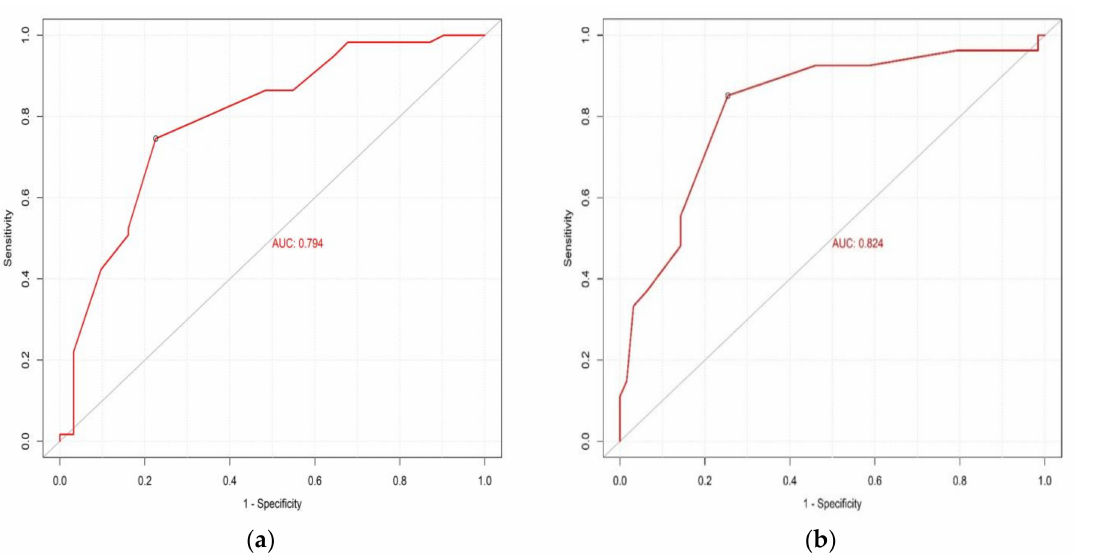
Figure 3. ( a ) Discriminative ability of CC to predict sarcopenia (CC~Sarcopenia). ( b ) Discriminative ability of CC to predict ASMM (CC~ASMM). ASMM (Appendicular Skeletal Muscle Mass); AUC (Area Under the Curve); CC (Calf Circumference); ROC (Receiver Operating Characteristic). Values are indicated in red color. The black circle refers to the CC cut point (set at 31 cm).